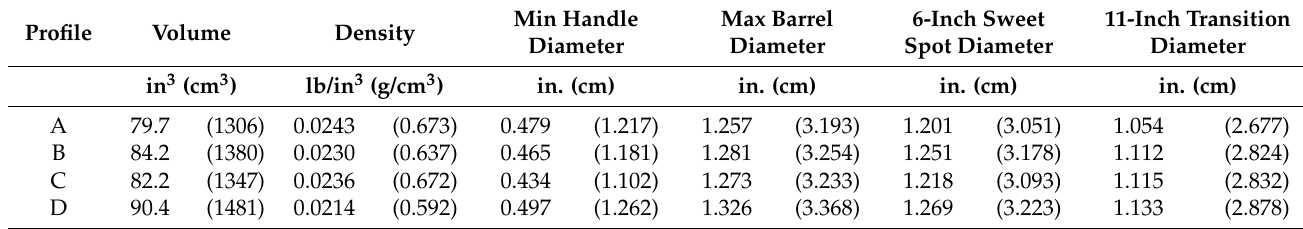
Figure 2. Bat profile overlay comparison. Bats are symmetrical along their long axis. Table 1. Bat Profile Measurement Comparison.